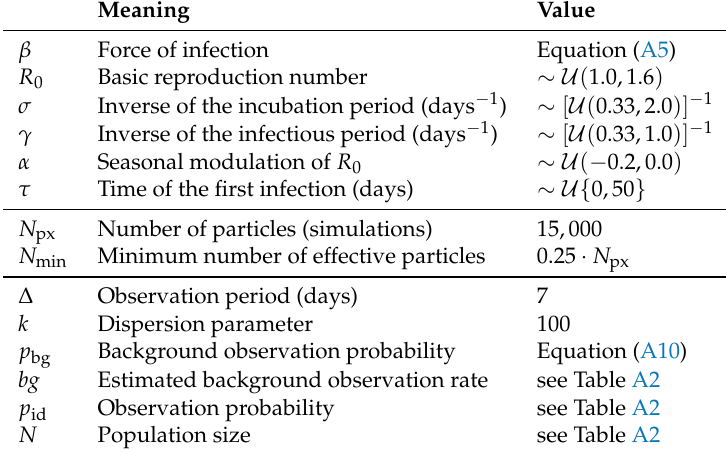
Table A1. Parameter values for: (i) the transmission model; (ii) the bootstrap particle filter; and (iii) the observation model. Here, U ( x , y ) denotes the continuous uniform distribution and U{ x , y } denotes the discrete uniform distribution, where x and y are the minimum and maximum values,